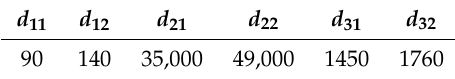
Table 4. Resource constraint levels ( 10 4 )